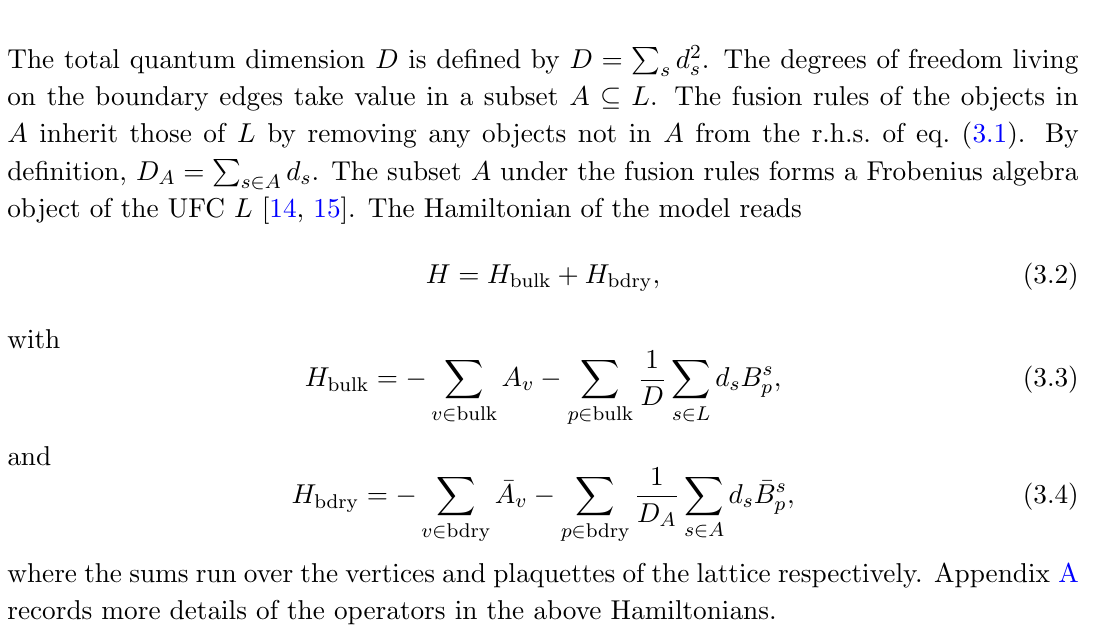
Figure 2 . The extended Levin-Wen model de(cid:12)ned on a hexagonal lattice embedded in a disk. Thick (thin) black lines are the bulk (boundary) edges of the lattice. The two red dots represent two (cid:28) (cid:22) (cid:28) ’s on the two plaquettes, for